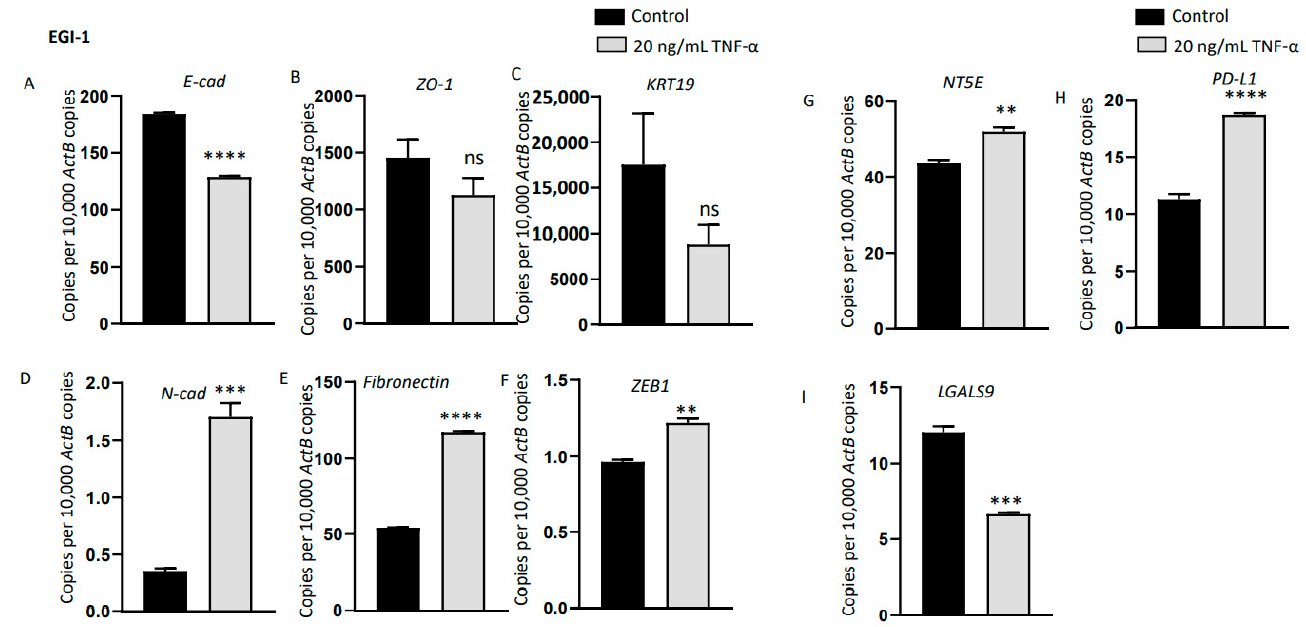
Figure 8. TNF- α -mediated EMT induced upregulation of immune modulators in CCLP-1 cells. ( A – F ) qRT-PCR showed reduction in the expression of epithelial markers E-Cad , ZO-1 and KRT19 , and elevation in the expression of mesenchymal markers N-cad , Fibronectin and ZEB1 after 72 h of TNF- α treatment in CCLP-1 cells. ( G – I ) qRT-PCR demonstrated elevated expression of immune modulators NT5E and PD-L1 and decreased level of LGALS9 upon 72 h of TNF- α treatment in CCLP-1 cells. Values are mean ± SD of three experiments in triplicate (** p < 0.01, *** p < 0.005, **** p < 0.001, ns: not significant). ActB: β -Actin.